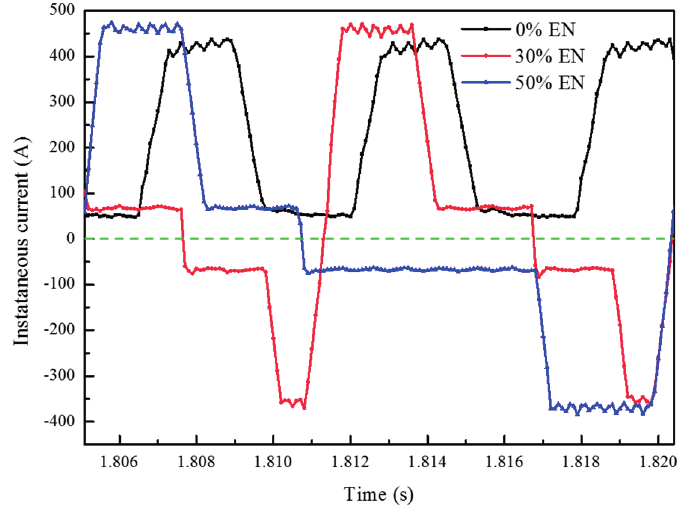
Figure 3. Current pulses at different EN (electrode negative)